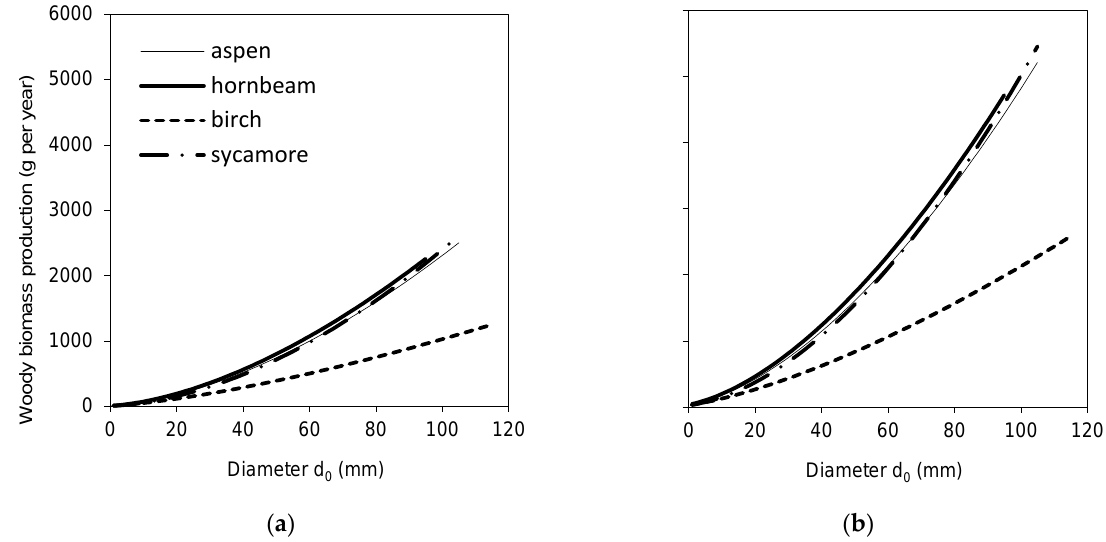
Figure 4. Species-specific models for leaf mass ratio (LMR) ( a ) and leaf area ratio (LAR) ( b ) against diameter d 0 (see Table 5 for Equation (1) parameters and statistical characteristics).